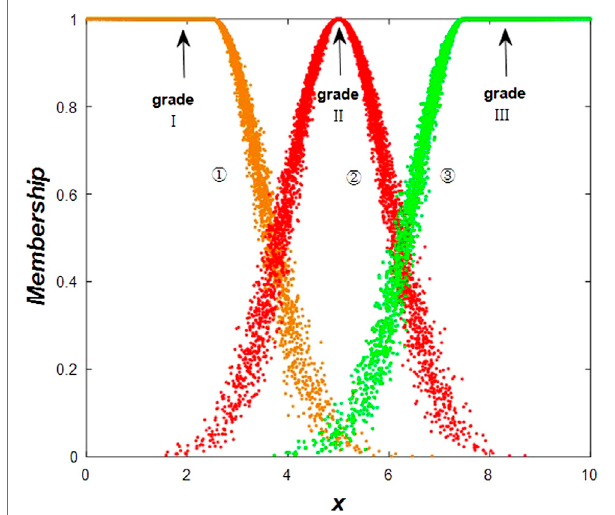
FIGURE 3 | Finite-interval cloud model cloud drop